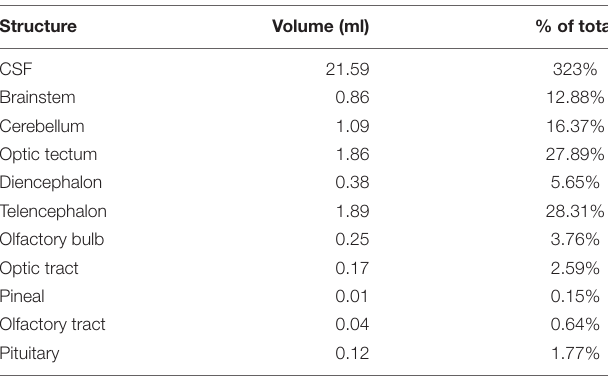
TABLE 3 | Brain structure volumes in milliliters (ml) and as percent of whole brain